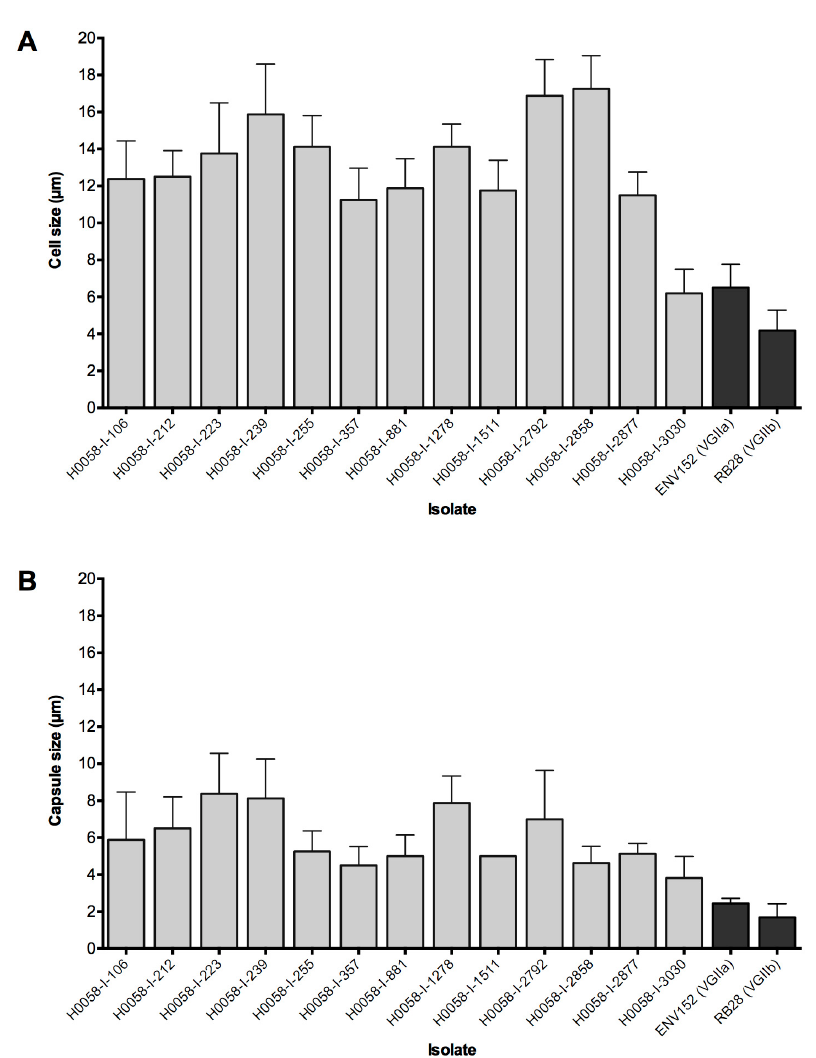
Figure 2. Distribution of the median and standard deviation of ( A ) yeast cell size and ( B ) capsule size of the studied Cryptococcus gattii VGII isolates. Light-grey and dark-gray columns represent isolates from Cucuta and Vancouver Island, respectively.